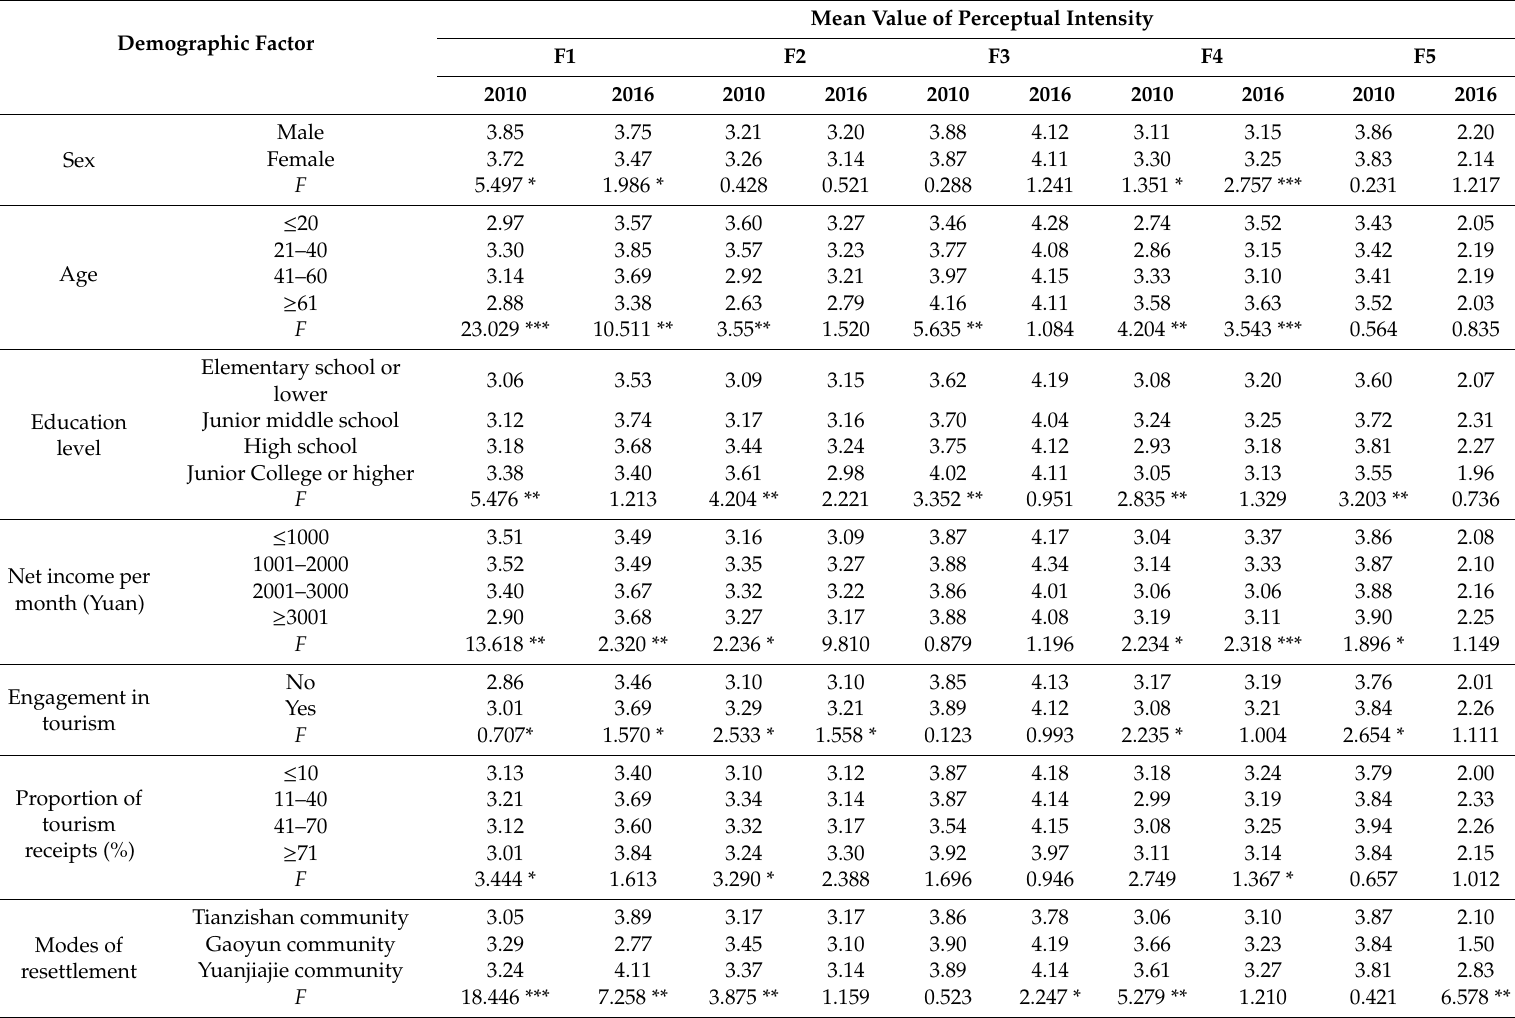
Table 3. Demographic profiles of factors on perception of ecological